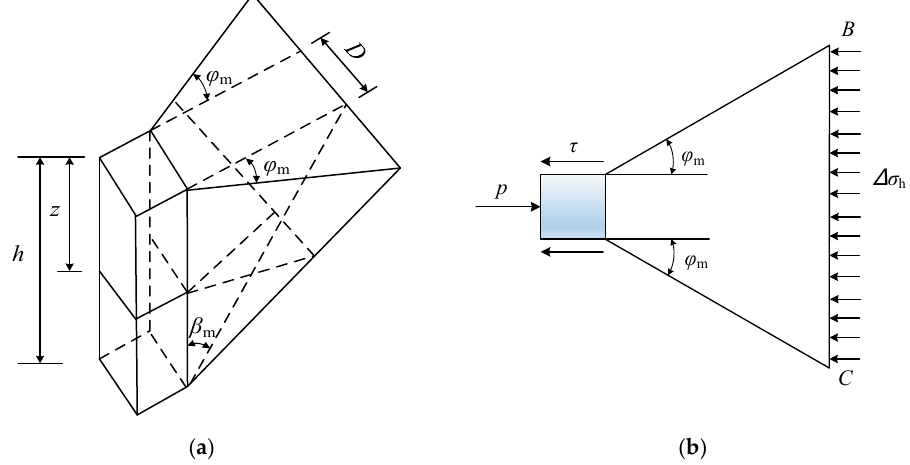
Figure 2. Strain wedge model: ( a ) three-dimensional view; ( b ) plan view.